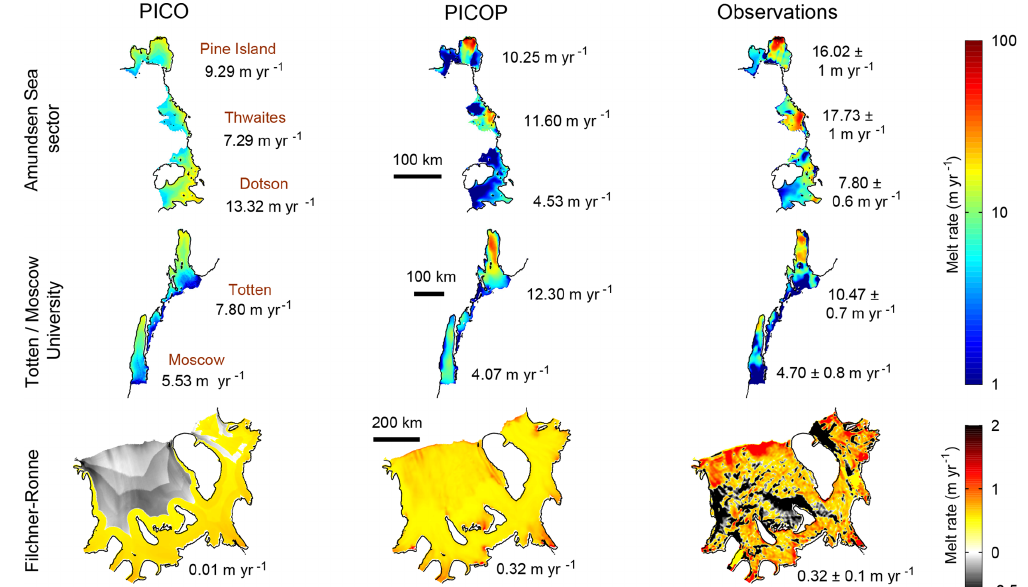
Figure 2. Modeled (PICO and PICOP) and observed (Rignot et al., 2013) melt rates (myr − 1 ) are displayed for the Amundsen Sea sector of West Antarctica (including Pine Island, Thwaites, and Dotson ice shelves), Totten and Moscow University ice shelves of East Antarctica, and the FRIS. Note that the upper color bar (Amundsen Sea sector, Totten, and Moscow University) is in log form while the lower color bar (FRIS) is linear. Numerical values under PICO and PICOP are area-weighted mean melt rates. The observed annual mean melt rate is displayed under the observed melt rate